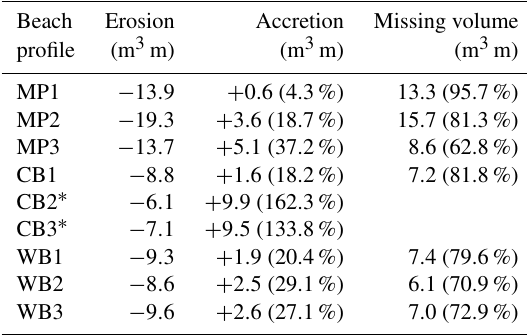
Table 6. Cross-shore beach profile changes above 2m AHD. Brack- eted values show percentage of eroded